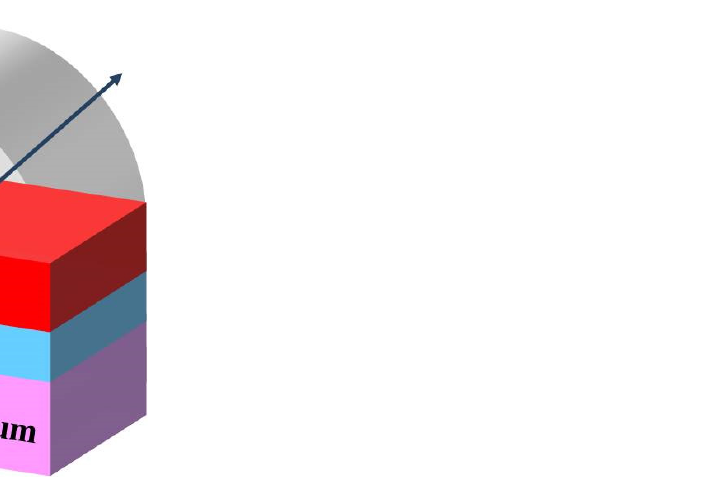
Figure 2. Diagrammatic presentation of the GeS combined on Al/Ag/Au SPR biochemical sensors for improved sensitivity.